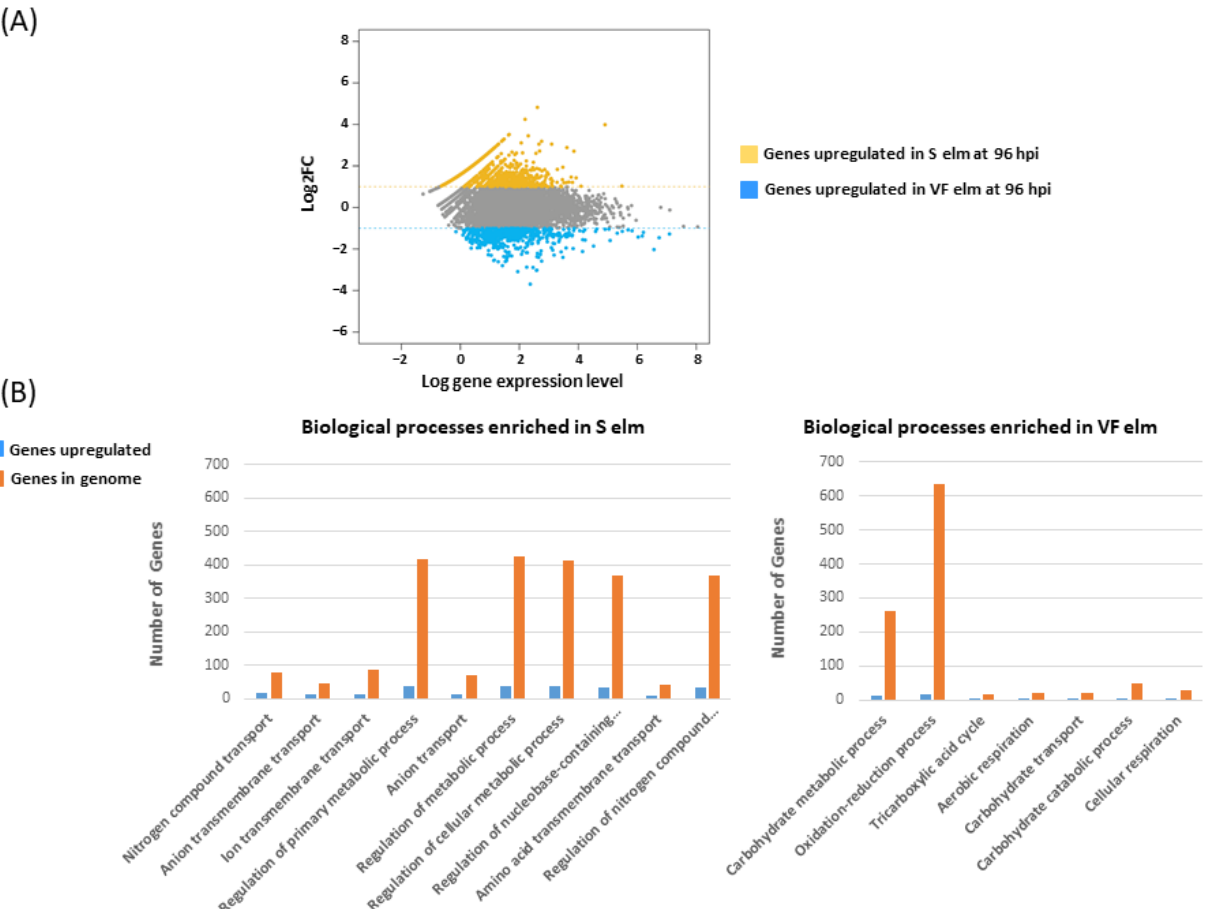
Figure 1. Differentially expressed Ophiostoma novo-ulmi genes during interaction with Ulmus americana . ( A ) MA plot of the 6424 O. novo-ulmi genes that were detected at 96 hpi showing genes that were overexpressed in susceptible (S) and resistant (VF) elm genotypes. Read counts were normalized using DESeq2 in R [56] with log 2 FC > 1 and scatter plot visualization. ( B ) Gene ontology (GO) terms for biological processes that were significantly enriched in O. novo-ulmi colonizing susceptible (S) or resistant (VF) elm genotypes. The top 10 processes are shown in the case of interactions with S elm (out of 39 GO terms for biological processes), whereas all enriched terms for processes are shown in the case of interactions with VF elm.